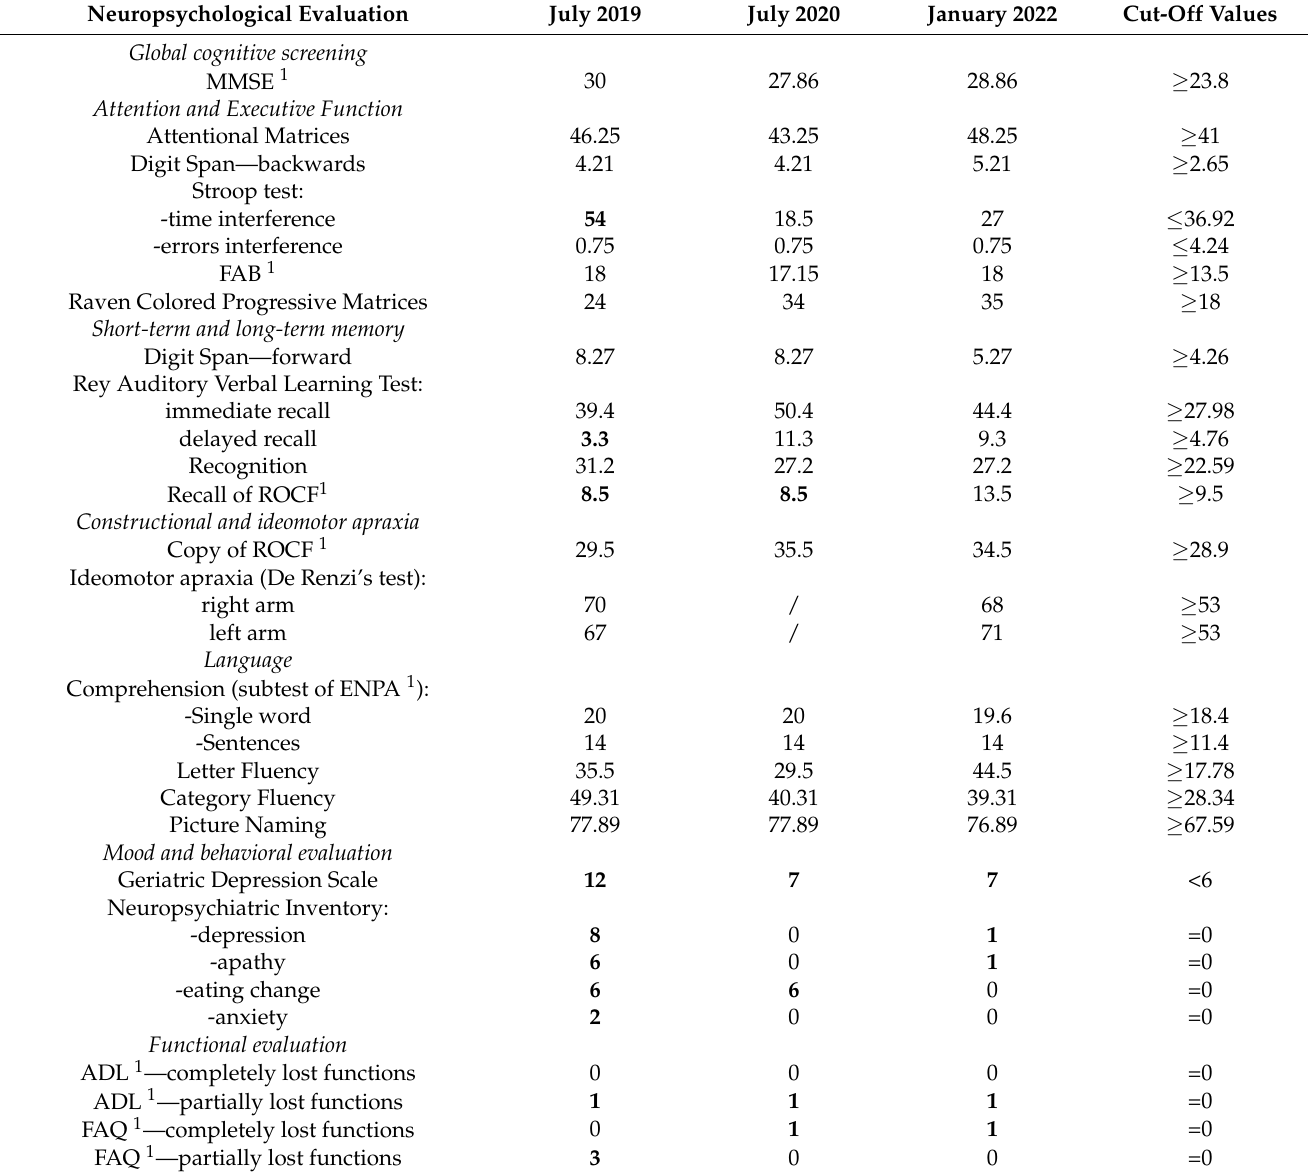
Table 1. Corrected scores on neuropsychological test; pathological values are highlighted in